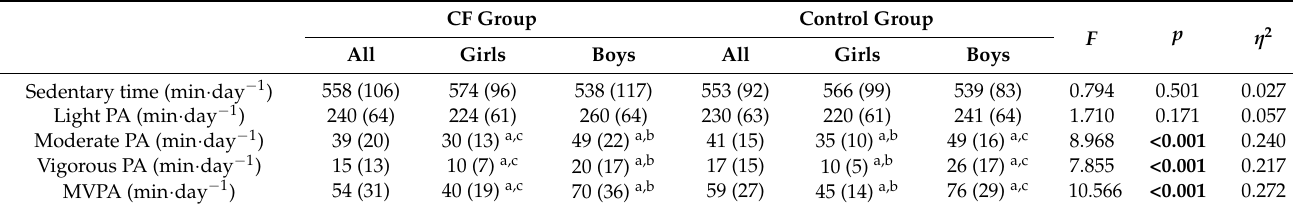
Table 2. Differences in physical activity and sedentary behaviour between cystic fibrosis patients and control group by